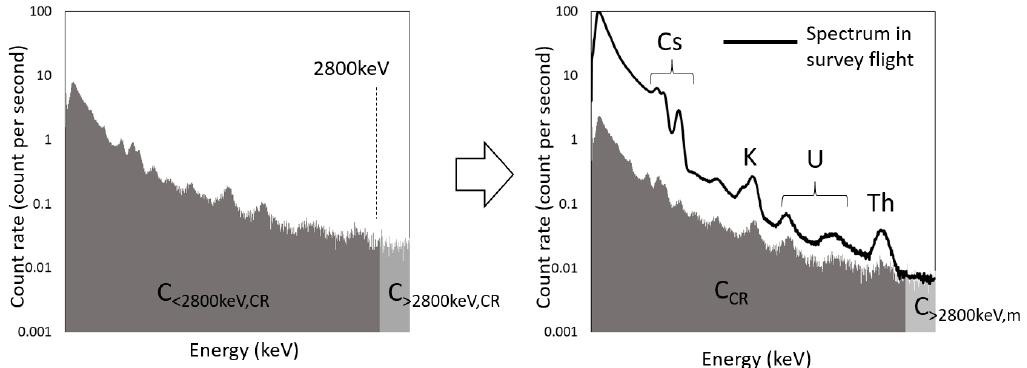
Figure 3. Images of subtracting background caused by cosmic rays.